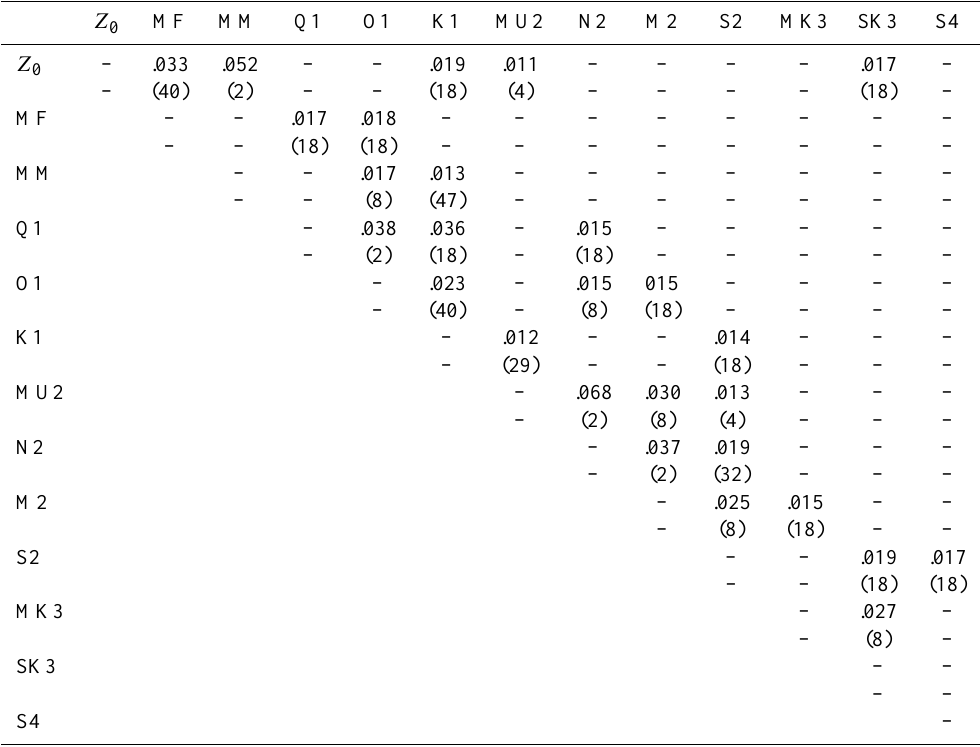
Table 3. Correlation coefficients (not diagonal) larger than 0.01 between the constituents of Table 1. The numbers in parenthesis correspond to the stations of Table 1.